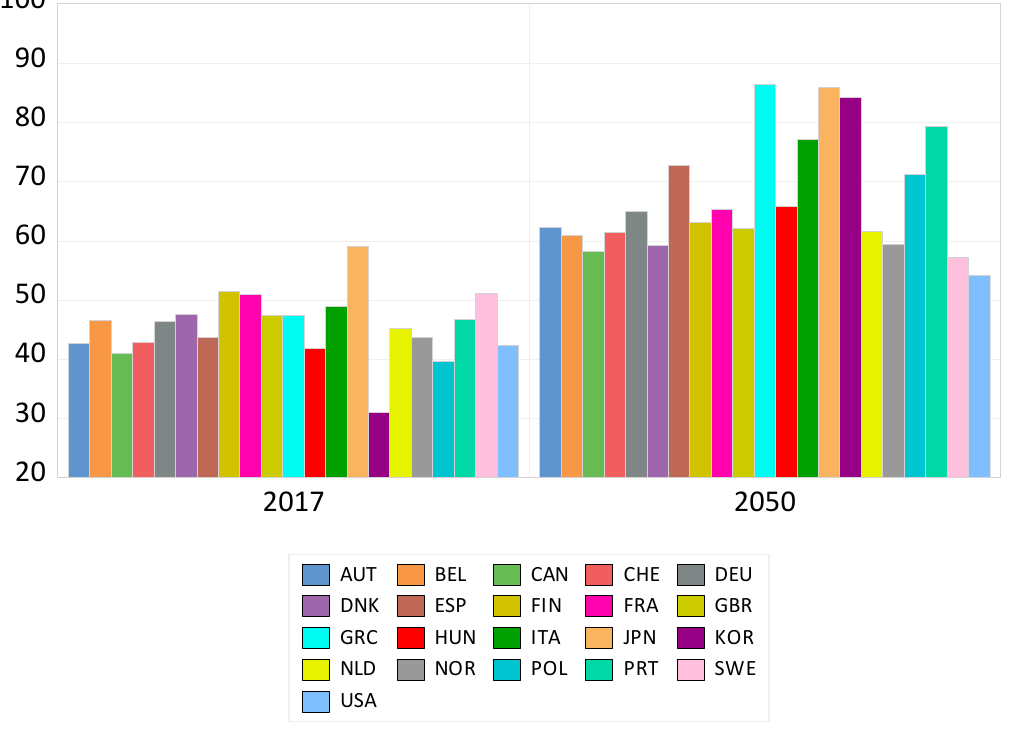
Figure 4. Change in the dependency rate of OECD countries (Unit: %). (Source: OECD Labor Force Statistics)